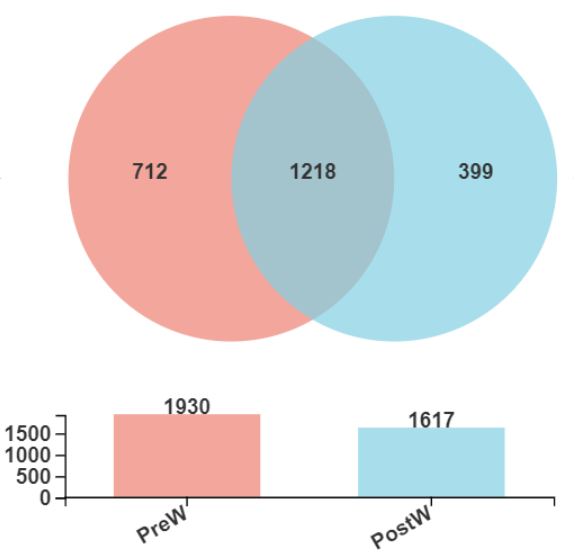
Figure 2. Venn diagram presenting the distribution of oral bacteria community OTUs between preweaning and postweaning donkeys. PreW, preweaning group; PostW, postweaning group. The oral bacteria with a relative abundance of more than 1% of the total sequences in at least one of the samples were further analyzed (Figure 3). The six predominant phyla were Firmicutes (40.4~61.1% of the total sequence reads), Proteobacteria (24.0~37.6%), Acti- nobacteriota (9.0~10.8%), Bacteroidota (3.3~6.5%), Fusobacteriota (1.5~1.7%), and Patescibacteria (0.5~2.1%).